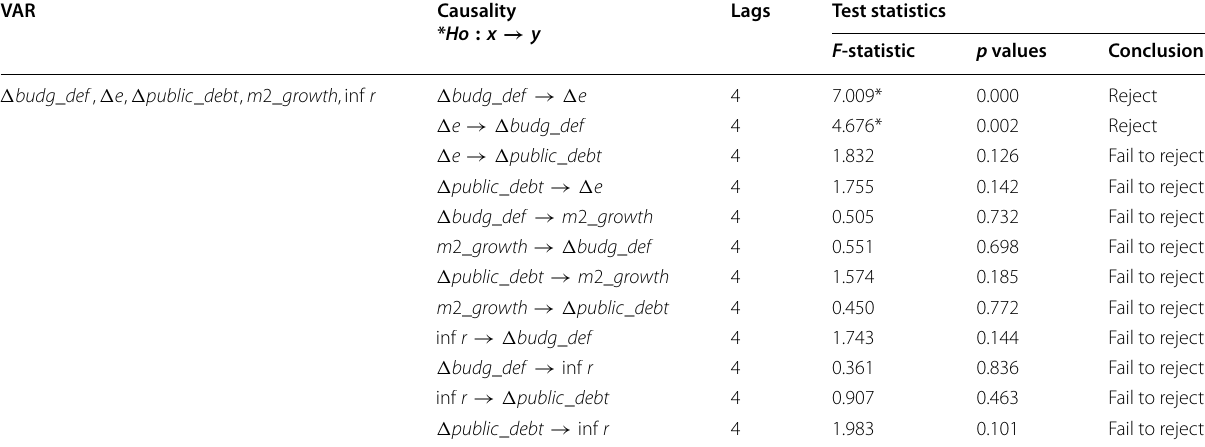
*The null hypothesis is that x does not granger cause y , indicated as x → y . If failed to reject, it means x does not granger cause y and if rejected, then it granger causes. *It shows significance at the 1% critical values.